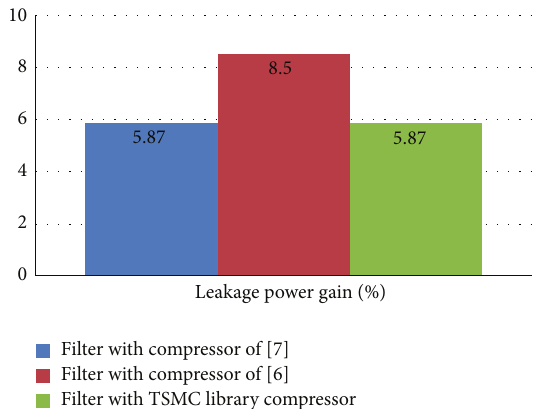
Figure 4: Comparison of leakage power % gain of proposed filter and existing